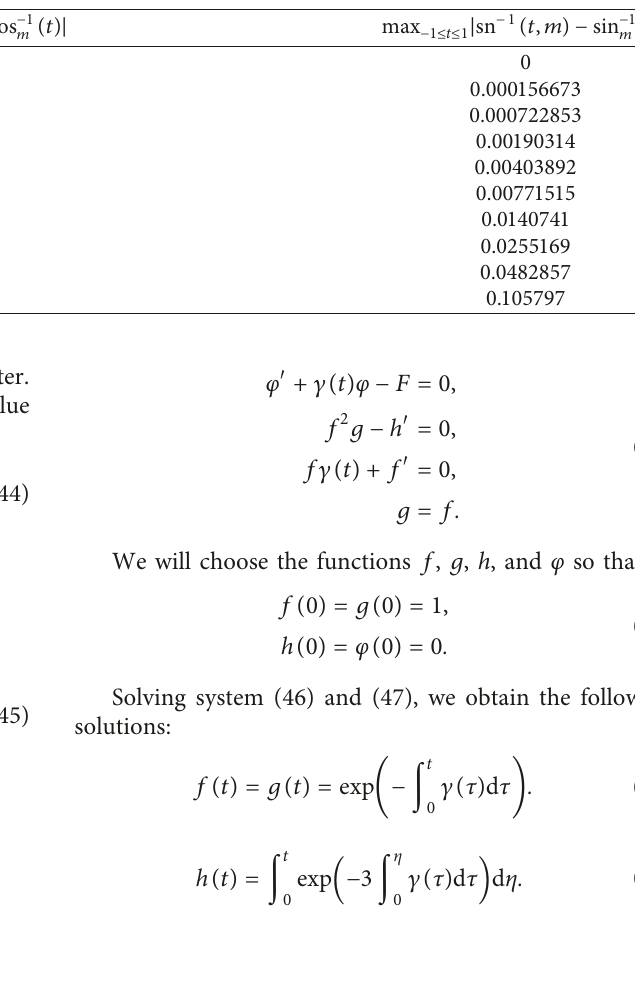
Table 2: Numerical values of approximations (40) and